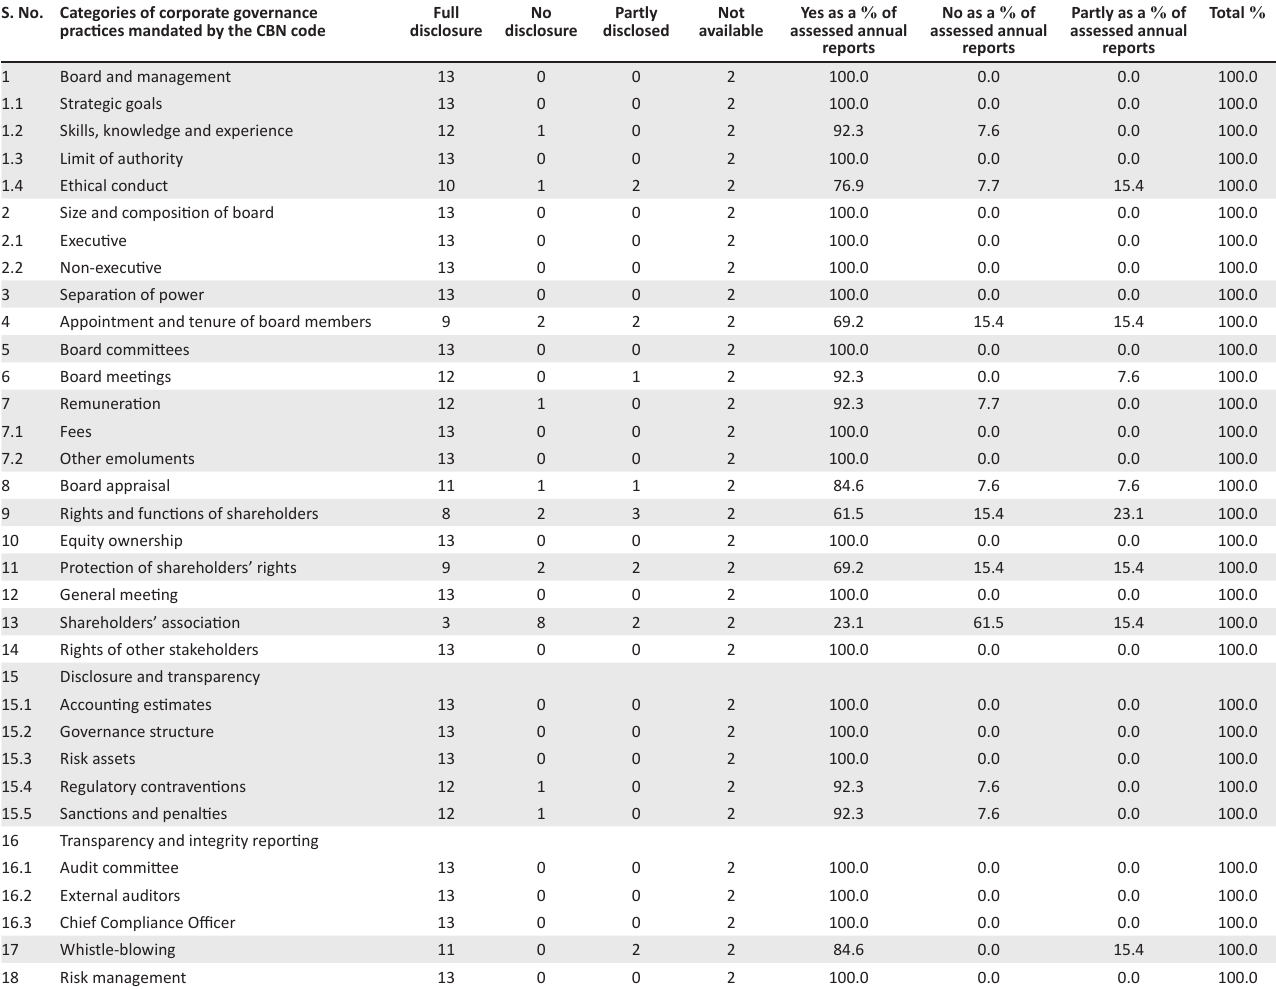
TABLE 6: Content analysis: 2017 Annual Reports of Nigerian banks. S. No. Categories of corporate governance practices mandated by the CBN